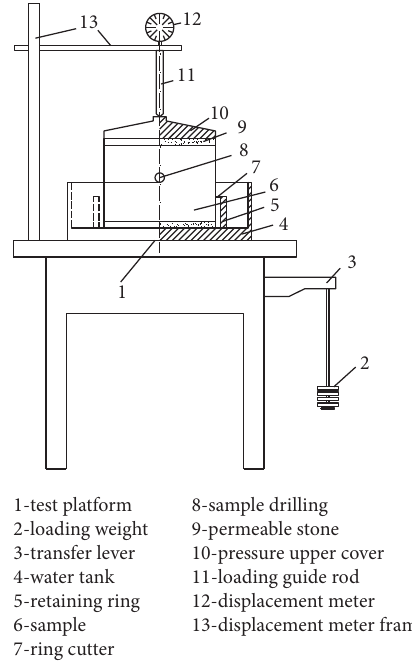
Figure 1: Schematic diagram of the test: 1, test platform; 2, loading weight; 3, transfer lever; 4, water tank; 5, retaining ring; 6, sample; 7, ring cutter; 8, sample drilling; 9, permeable stone; 10, pressure upper cover; 11, loading guide rod; 12, displacement meter; 13, displacement meter